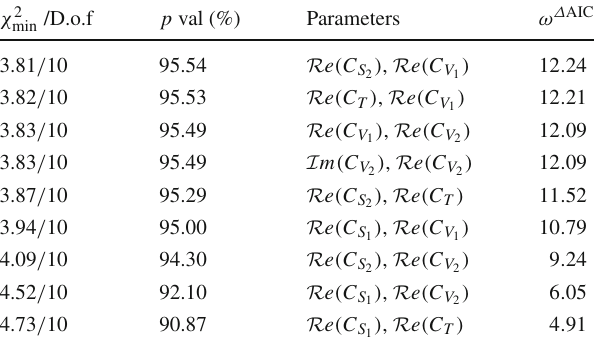
Table 10 Scenarios selected after passing the criterion Δ AIC c ≤ 2 for the analysis considering the synthetic data points along with all data available (without R J /ψ ) χ 2 /D.o.f min